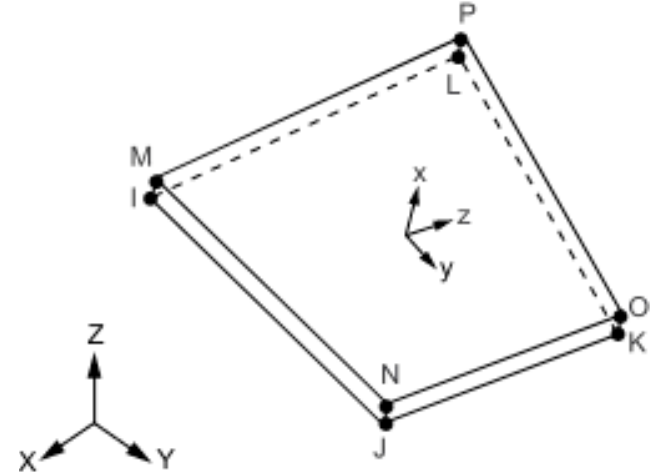
Figure 8. The geometry of interfacial contact pair elements.